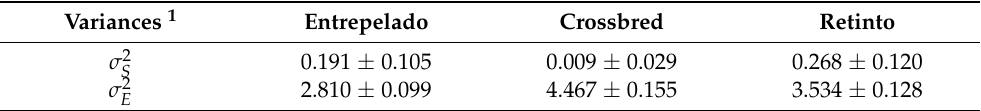
Table 4. REML estimates ± standard error (SE) of the permanent environmental and residual variances for the total number born (TNB) in the Entrepelado, Crossbred and Retinto populations. Variances 1 Entrepelado Crossbred Retinto 0.191 ± σ 2 S